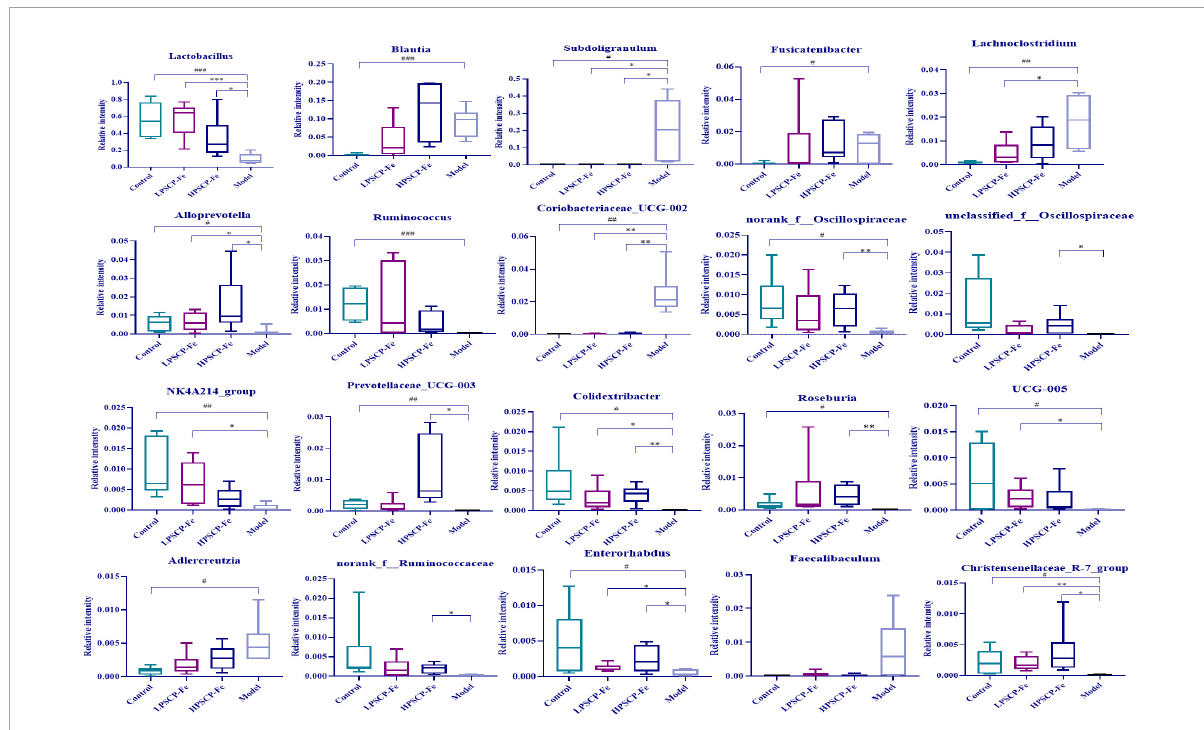
FIGURE4 Average relative abundance of difference features flora in feces of all groups. Data are presented as mean ± SD, n = 6. # p < 0.05, ## p < 0.01, ### p < 0.001: control vs. model; ∗ p < 0.05, ∗∗ p < 0.01, ∗∗∗ p < 0.001: treatment vs.